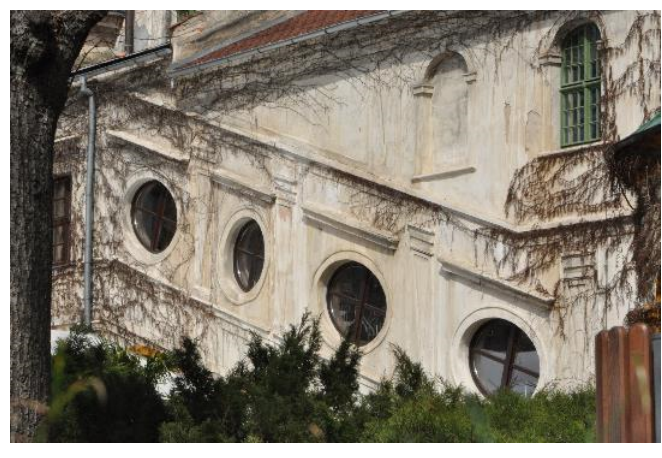
Figure 1 e castle in Otmuchów (SW Poland) owned by the family of von Humboldt until 1929 (Phot. A. Nowak, July